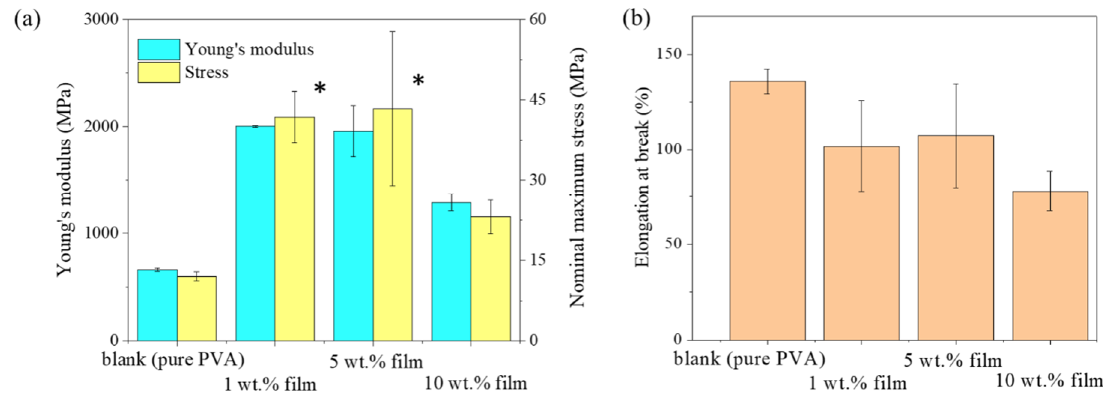
Figure 6. Mechanical properties of pure PVA and hemp / PVA composite films: ( a ) Young’s modulus and nominal maximum stress ( b ) Elongation at break (%). * denotes significant difference ( p ≤ 0.05) was found between data. Table 2. Statistical indicator: p -value * of multiple comparisons of films’ mechanical properties. Young’s Modulus